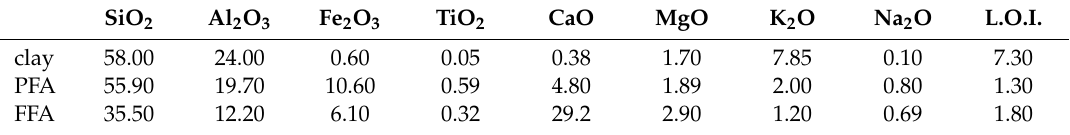
Table 1. The chemical composition of illite, pulverized firing fly ash (PFA) and fluidized fly ash (FFA) (in mass%).